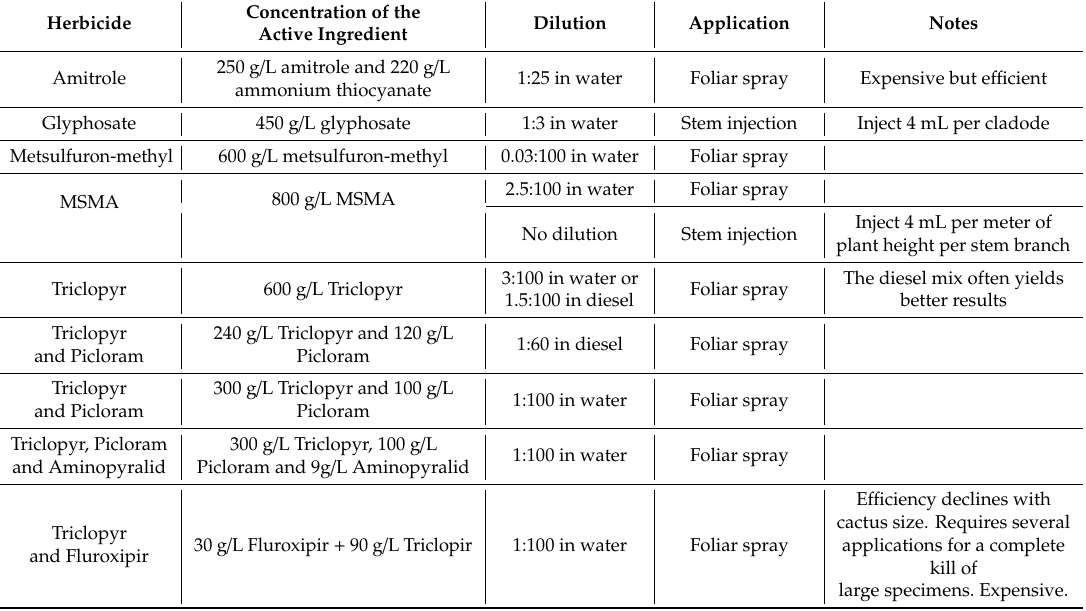
Table 3. Herbicides listed by questionnaire respondents and management reports as e ff ective for managing cactus invasions. It is important to note that the use of some of the listed herbicides might be banned or restricted in certain countries or in protected